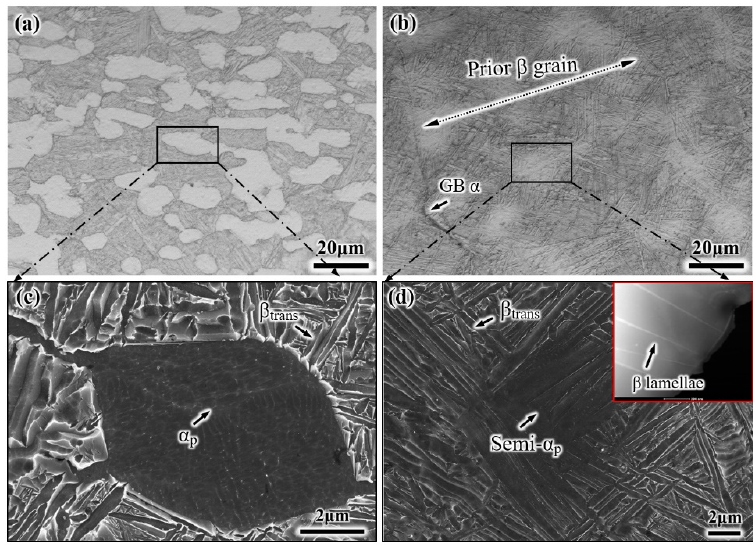
Figure 3. Typical microstructure after heat treatment: ( a , c ) EM and ( b , d ) S-EM. Table 2. Summary of the constituent phase parameters for the EM and S-EM.